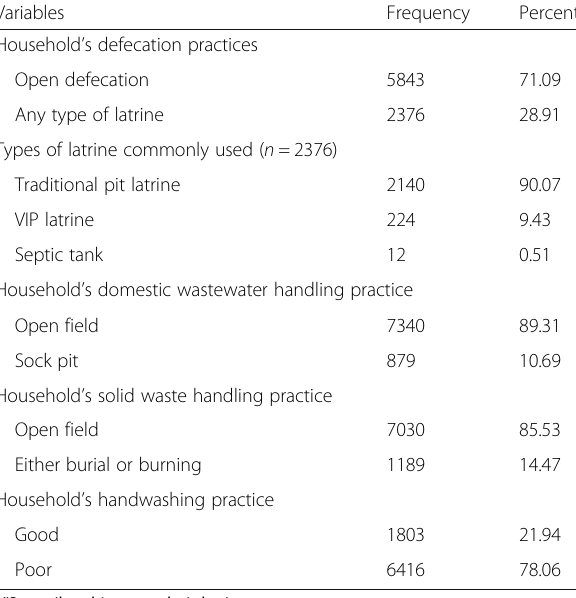
Table 4 Waste management practices in DHDSS sites,